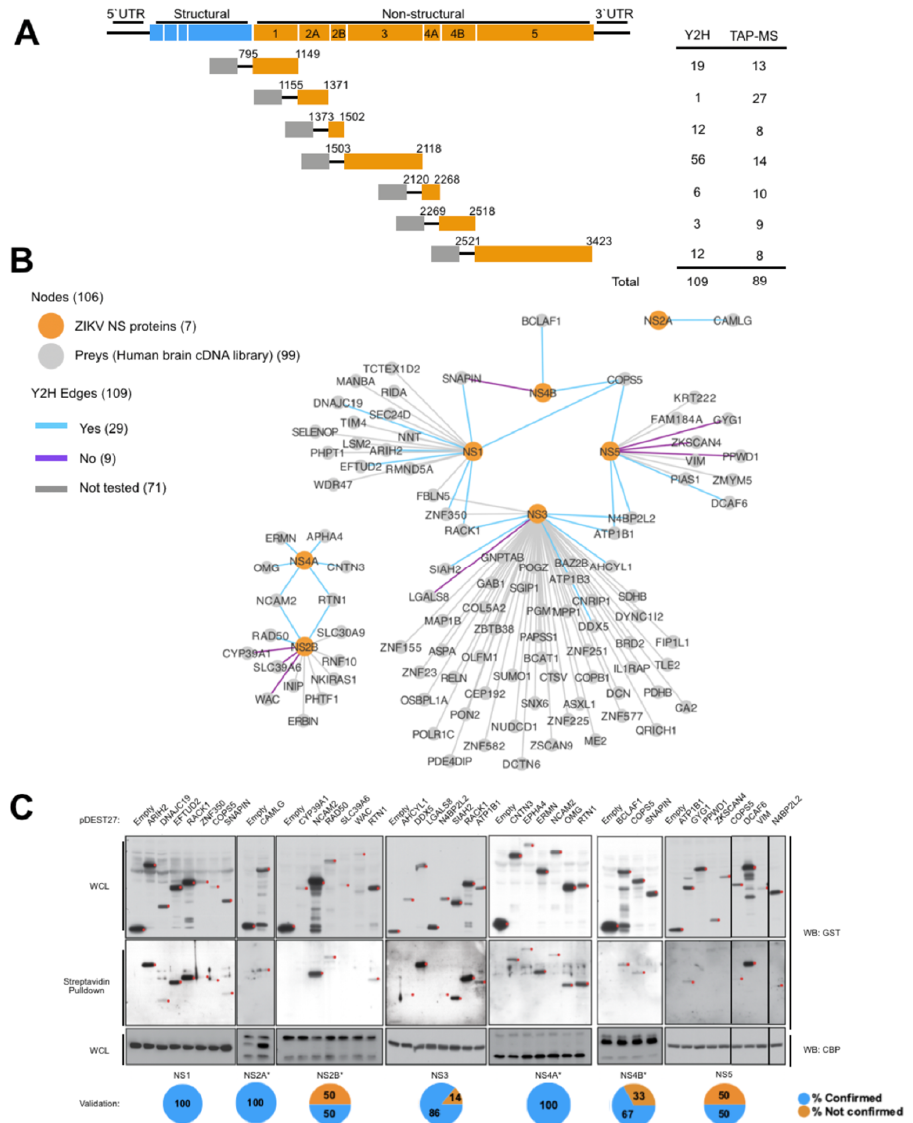
Figure 1. Yeast two-hybrid (Y2H) protein–protein interaction network (PIN). ( A ) Schematic representation of the ZIKA virus (ZIKV) genome and non-structural (NS) constructs used on our protein–protein interaction screenings. Grey boxes represent the GAL4 DNA binding domain (DBD) and the streptavidin binding protein (SBP)–calmodulin binding protein (CBP) tag used on the yeast two-hybrid (Y2H) and tandem affinity purification (TAP) assays, respectively. The number of hits identified by each assay and bait is summarized on the right. UTR, untranslated region. ( B ) Network of the interactions identified by Y2H screens. ZIKV NS nodes are colored in orange, and gray nodes indicate other proteins that were recovered as preys. Edge colors represent results from validation. Edges to all preys are shown and ‘not validated’ (No), ‘validated’ (Yes), and ‘not tested interactions’ (Not tested), and are denoted by blue, purple, and gray edges, respectively. The color legend is depicted on the upper left-hand corner. ( C ) Streptavidin pulldown of TAP-tagged NS constructs from 293FT whole cell lysates followed by Western blotting with the indicated antibodies. The individual percentage of hits validated by bait is depicted on the right. Red dots indicate the expected band size. Red asterisk for Streptavidin pulldown